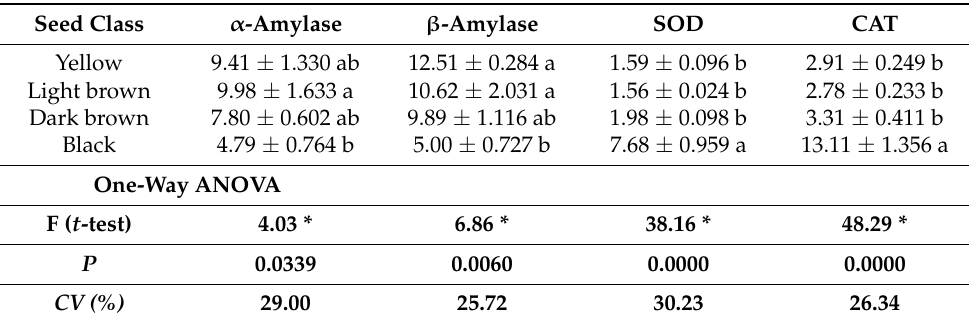
Table 4. α -amylase (mg maltose/mg protein), β -amylase (mg maltose/mg protein), superoxide dismutase (SOD) (unit of SOD/min/mg protein) and catalase (CAT) ( µ mol/min/mg of protein) activities in different Pterodon pubescens seed classes. Seed Class α -Amylase β -Amylase SOD